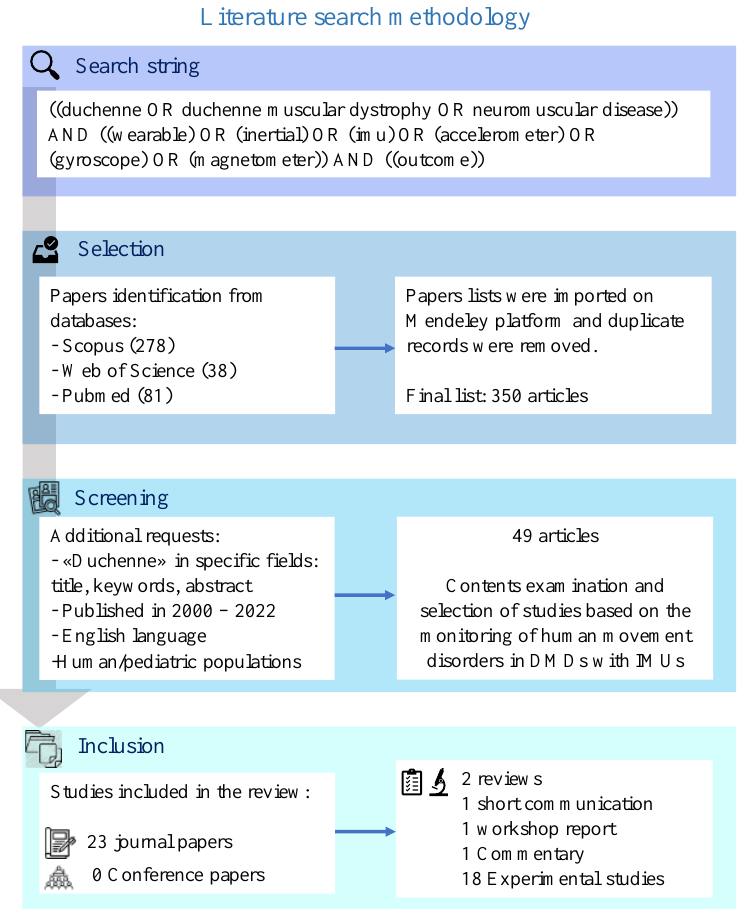
Figure 1. Flowchart describing the several paper selection steps in the literature search.